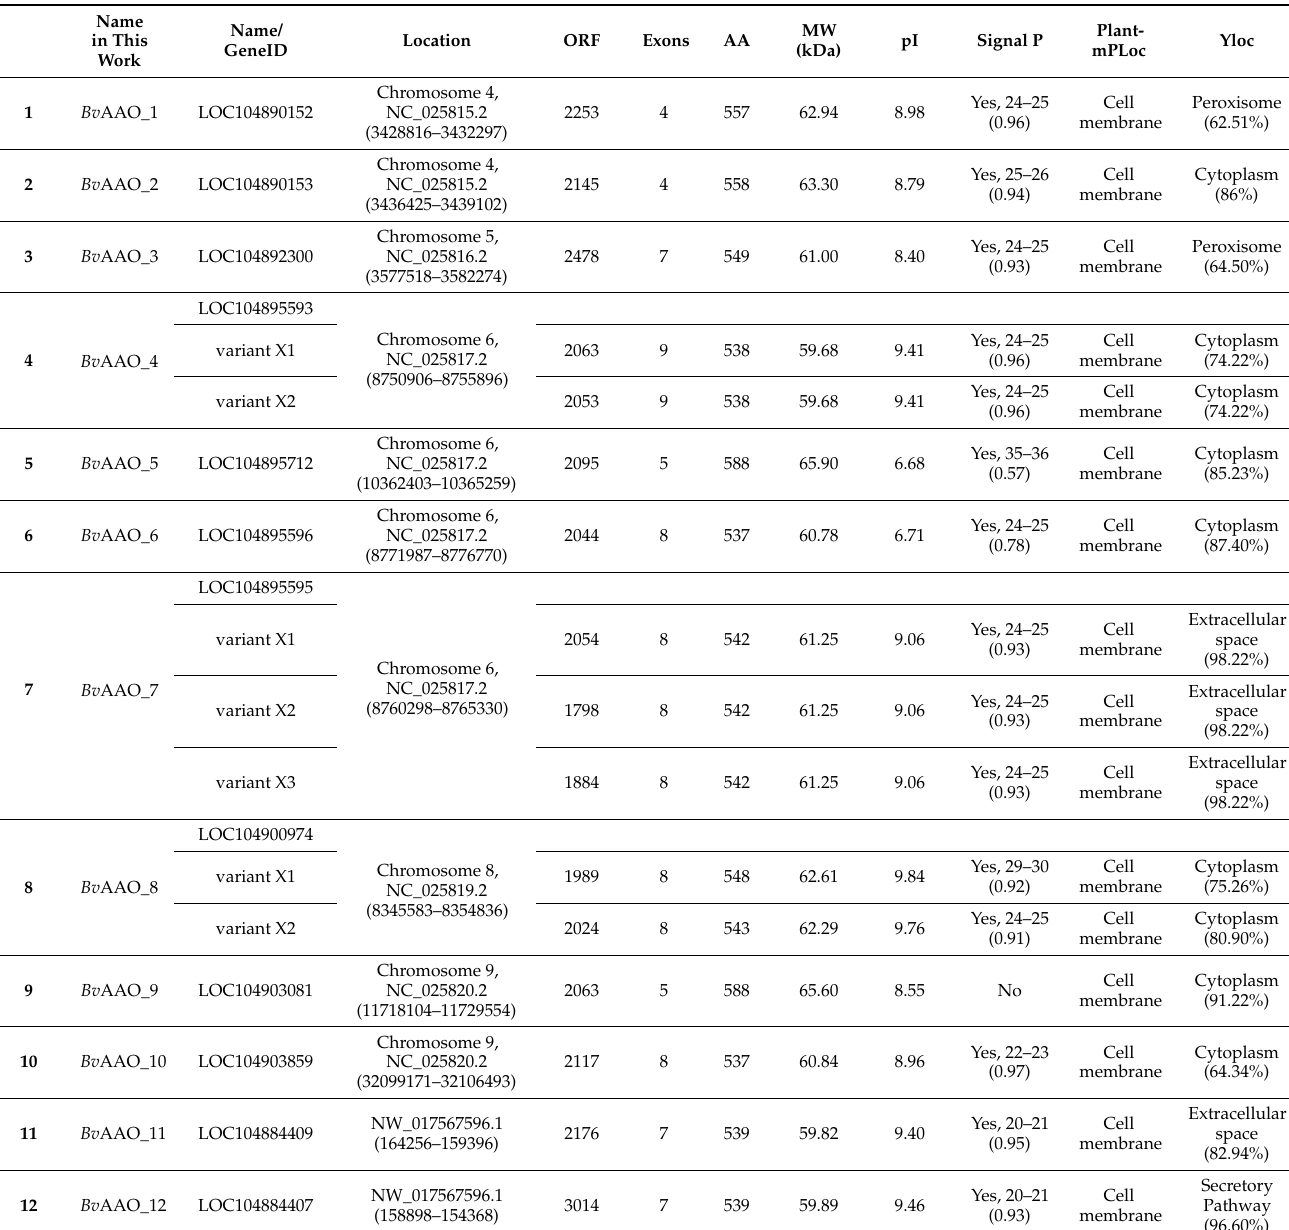
Table 1. Characteristics and properties of AAO genes and the proteins they encode in Beta vulgaris